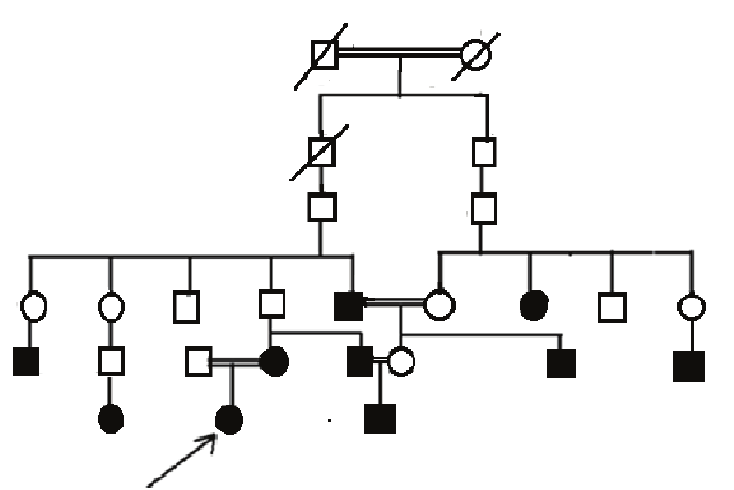
Figure 2 : Pedigree of the second family from the Northern State, Sudan with familial Bell’s palsy with 10 (6 male and 4 female) affected individuals across three generations. The black arrow shows the index